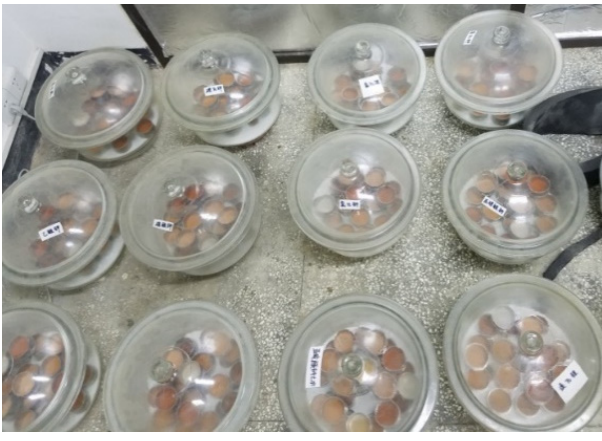
Figure 2. Isothermal adsorption